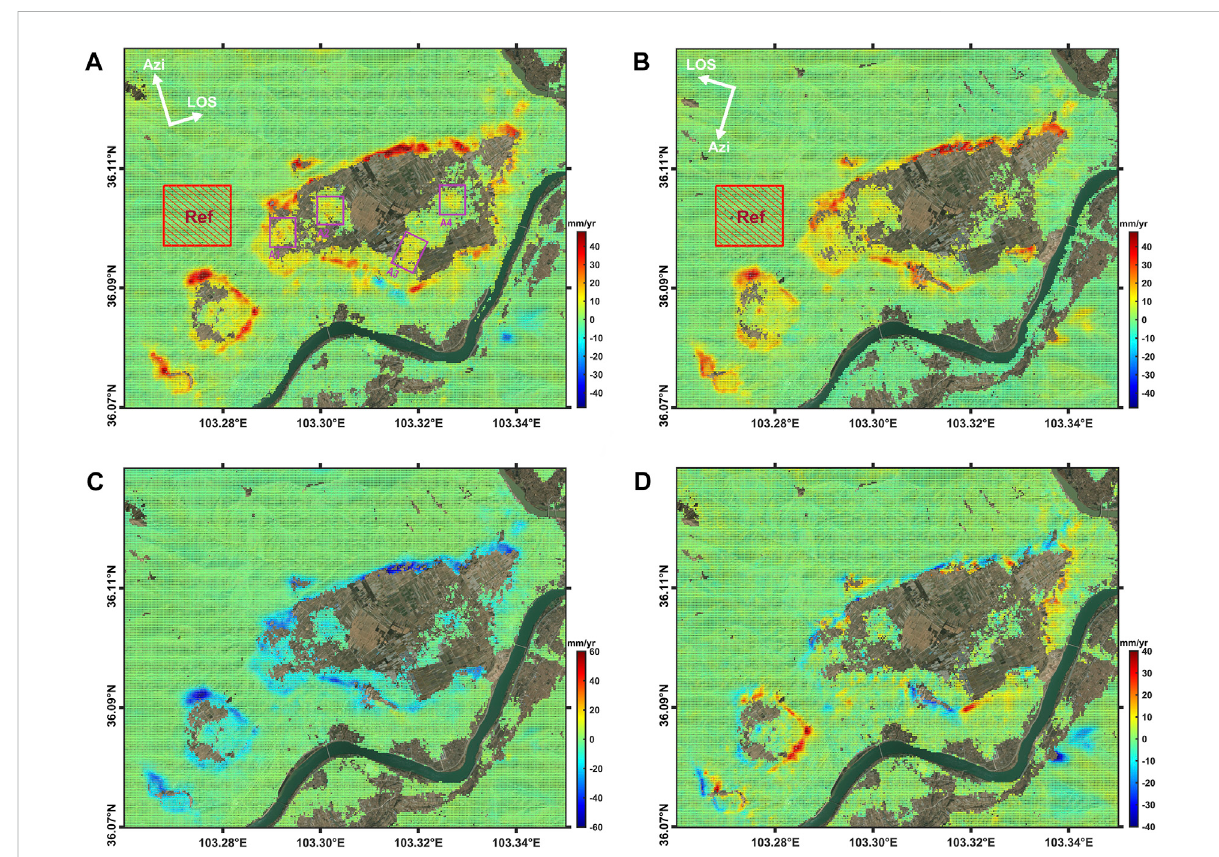
Spatial pattern overlaying the optic image for the mean velocities in (A) ascending LOS direction, (B) descending LOS direction, (C) vertical direction, and (D) east – west direction. In (A,B) , red means moving away from the satellite and blue means moving toward the satellite along the radar ’ sLOS direction asindicatedattopleft.In (C,D) ,red indicatestheupwardmovementand eastwardmovement,respectively. The reference area isselectedto befar from theterraces and the Yellow River denotedas ‘ Ref ’ . A1, A2, A3, and A4 in purple boxes are thefour regions on theHeitai platform with evident